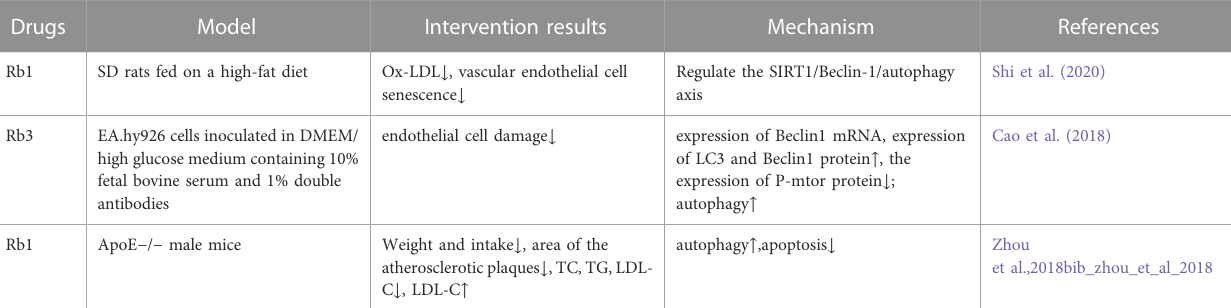
TABLE 4 Ginsenosides reduce oxidative stress by promoting autophagy.